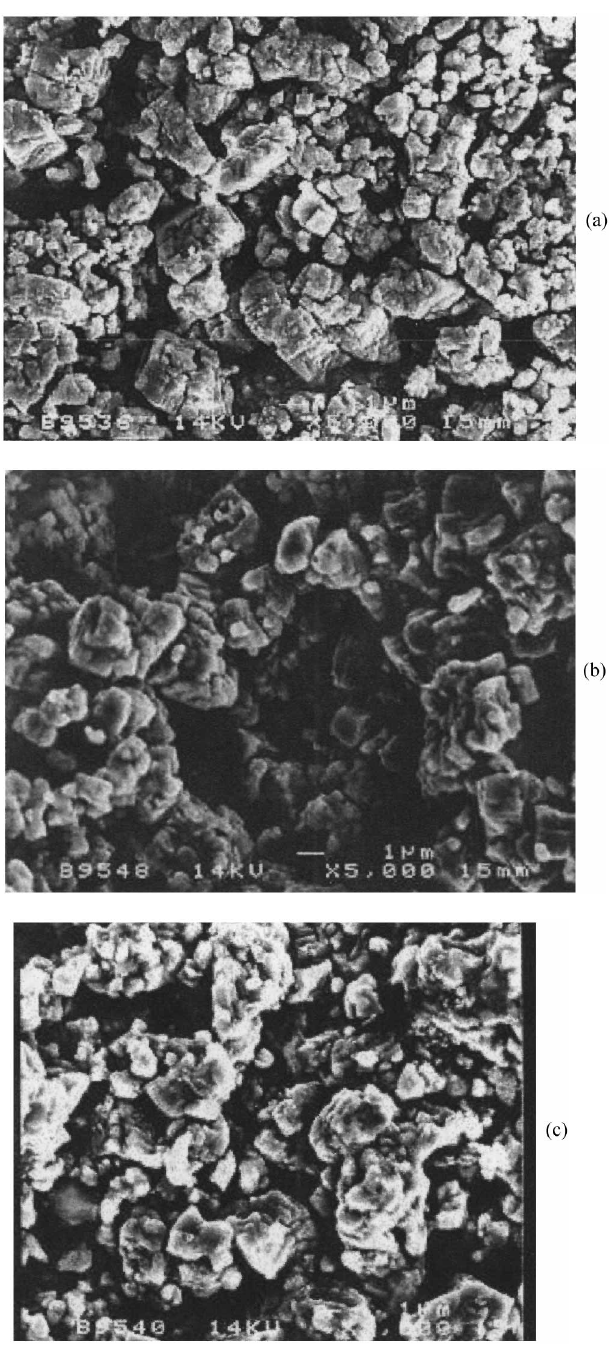
FIGURE 5 Microstructure of the SSR-derived SrSnO 3 material system sintered at 1200 (cid:1) C with soak-time (a) 24h, (b) 36h, (c) 48h, and (d)